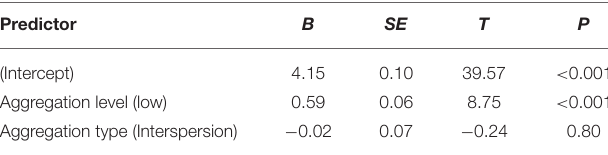
TABLE 4 | Parameter estimates in the linear mixed model for landscape preference rating as a function of aggregation